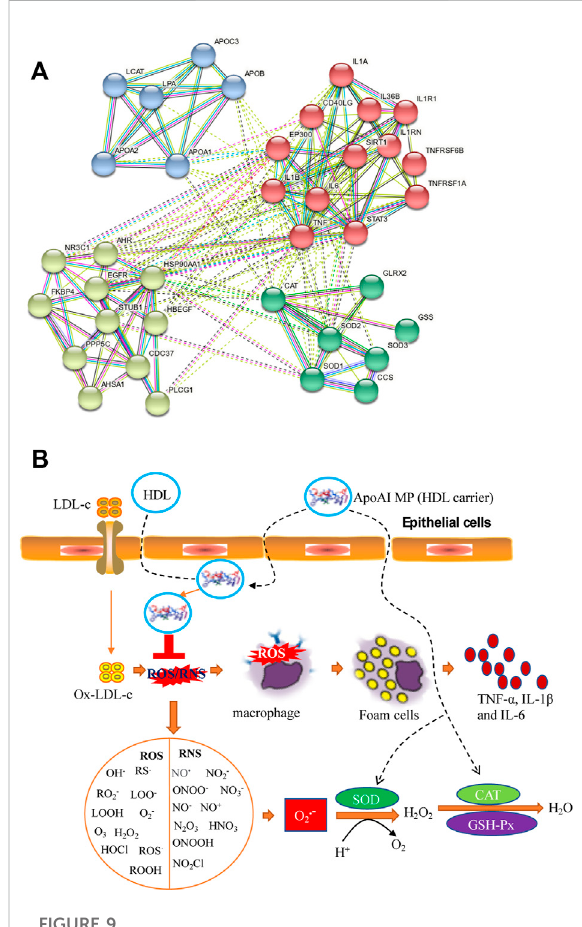
The possible mechanism for the functional role of ApoAI MP in the prevention of PD progression. (A) , the interactions among ApoAI, in fl ammatory cytokines and antioxidants. (B) , the possible pathway for the functional role of ApoAI MP. ROS and RNS produced by lipid peroxidation and in fl ammatory situation. ROS are grouped as oxygen-free radicals and RNS are grouped as nitrogen-freeradicals,includinghydroxylradical( · OH),superoxide (O 2 · − ), peroxyl radicals (RO 2 · ), sulfonylradicals (ROS · ), thiyl radicals (cid:129) (RS · ), single oxygen (O 2 ), hydrogen peroxide (H 2 O 2 ), hydrogen peroxide and hydroperoxides (ROOH), ozone (O 3 ), hypochloride (HOCl), nitric oxide (NO · ), peroxynitrite (ONOO − ), peroxynitrous acid (ONOOH), nitronium (NO 2 + ), dinitrogen dioxide (N 2 O 2 ), and related nitrogen oxides (N 2 O 3